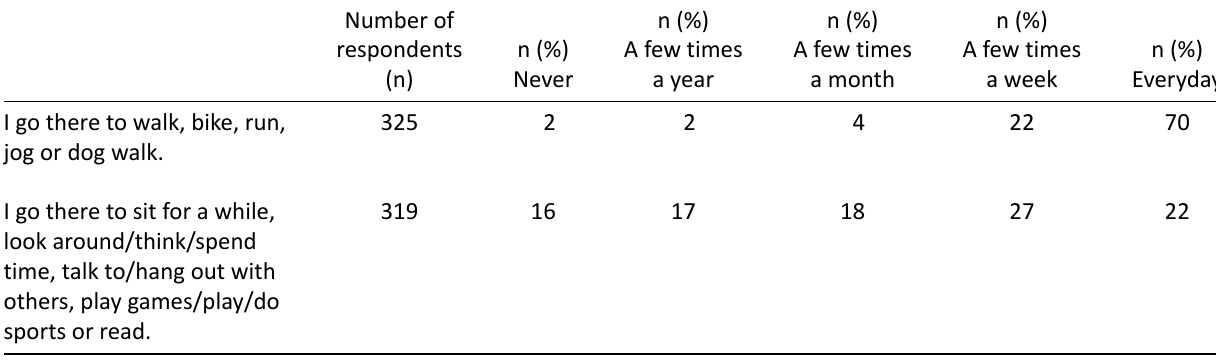
Table 1. Frequency of activities the respondents do close to at least one of the blue-green solutions. Number